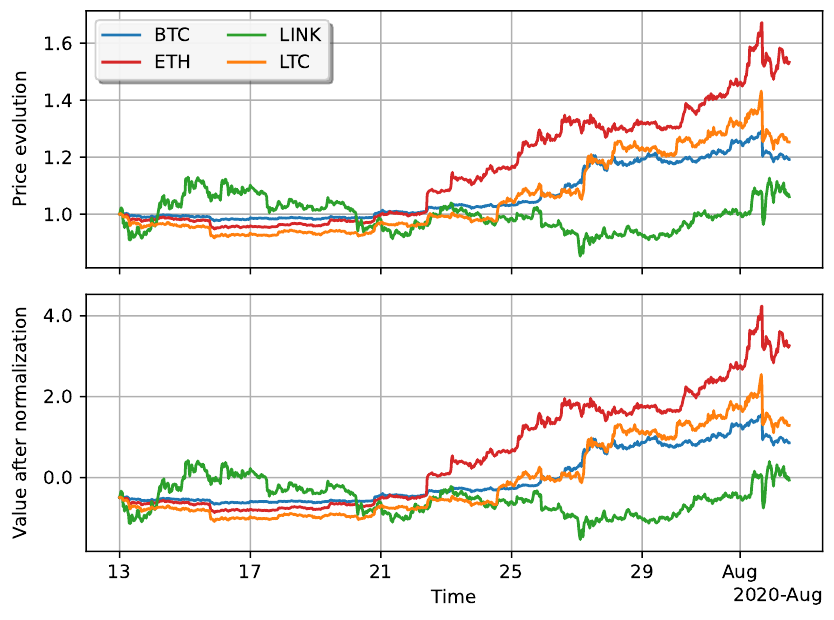
Figure 7. Raw data vs. normalized data.